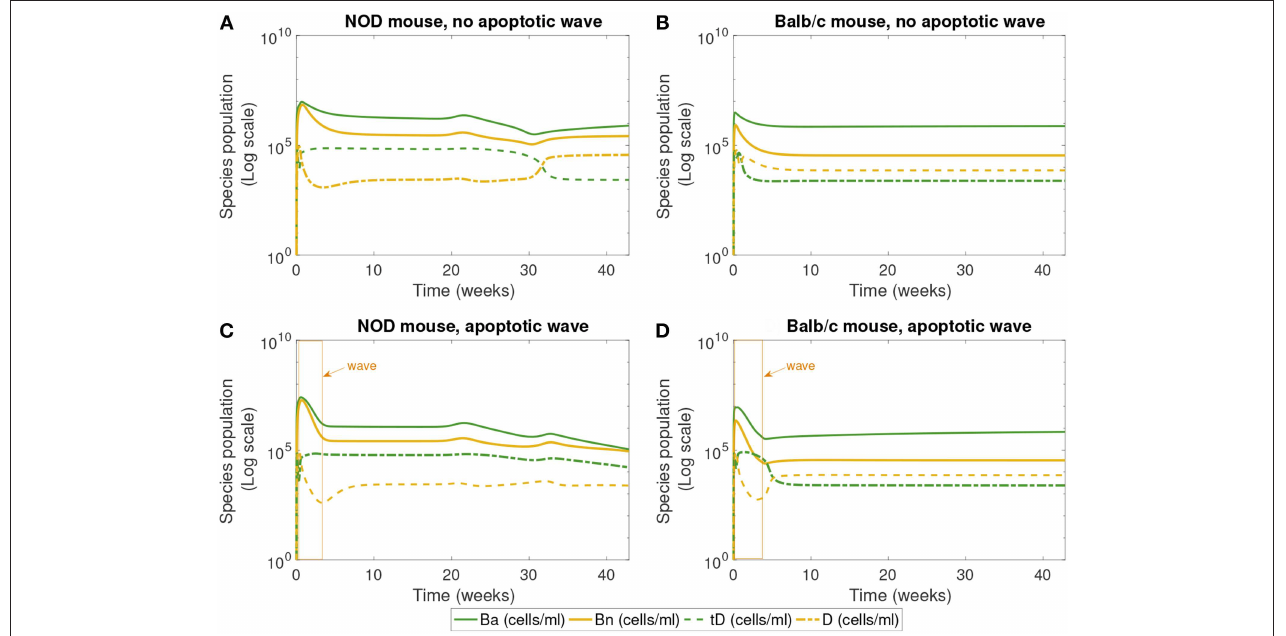
FIGURE 4 | The populations of apoptotic β -cells ( B a ), necrotic β -cells ( B n ), tolerogenic DCs ( tD ), and immunogenic DCs ( D ), simulated for 40 weeks, according to the single compartment mathematical model. We compare the system in the presence and absence of an early wave of apoptosis, and between NOD and Balb/c mice. (A,C) Show that the NOD mouse exhibits higher levels of necrotic β -cells, which are thought to contribute to the development of T1D. In (C) , the NOD mouse in the presence of an apoptotic wave shows decreased apoptotic β -cells. (A) NOD mouse, no apoptotic wave, (B) Balb/c mouse, no apoptotic wave, (C) NOD mouse, apoptotic wave, and (D) Balb/c mouse, apoptotic wave.